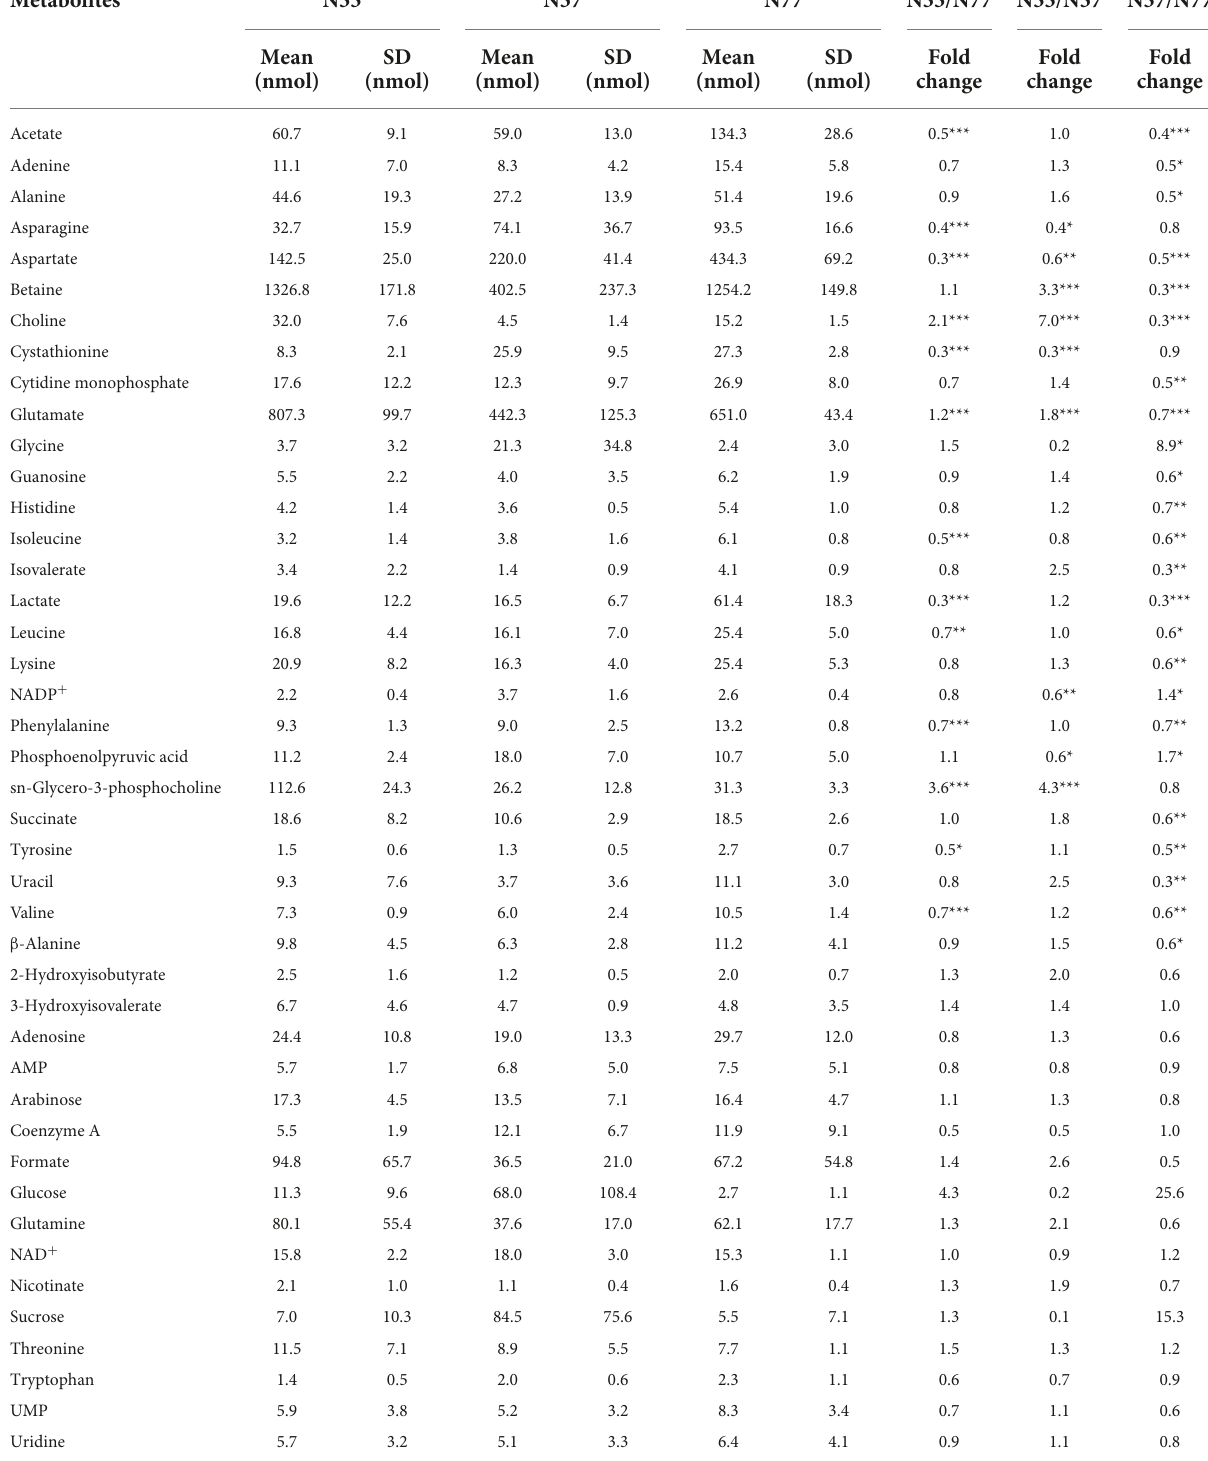
TABLE 1 Identified metabolites from S epidermidis 19N strain intracellular extract by 1 H-NMR with respective levels in each experimental condition.